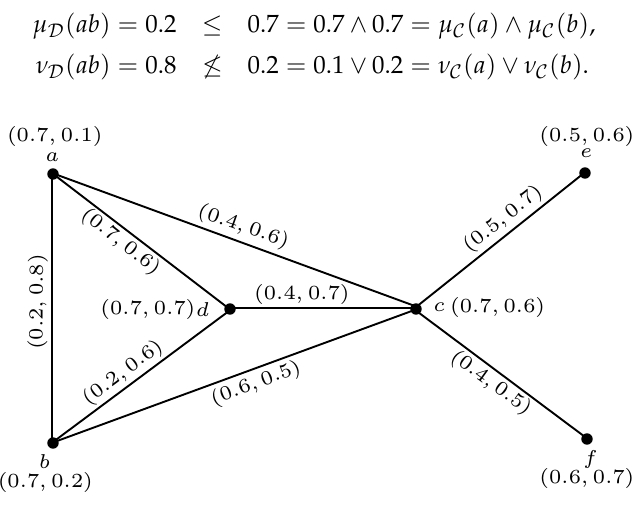
Figure 4.2: Union of two PFGs. Figure 17. Union of two PFGs.